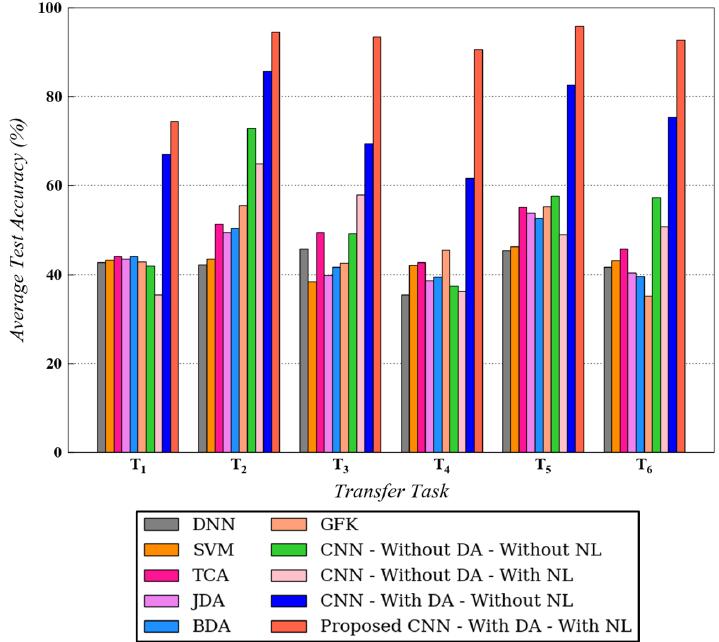
Figure 8. Testing diagnosis performances on target domain for different transfer tasks using different algorithms on Paderborn dataset. N S = 400 is